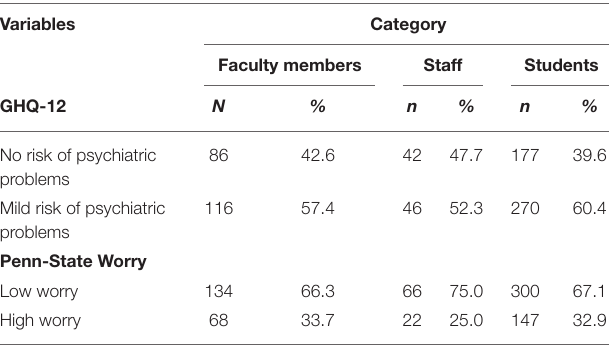
TABLE 2 | The prevalence of mild risk of psychiatric problems and worry among faculty members, staff, and students during the COVID-19 pandemic. Variables